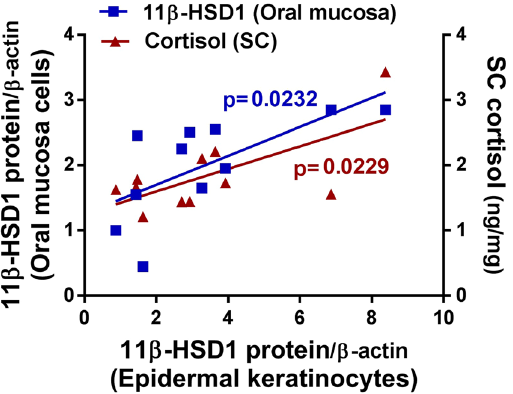
Figure 2. Expression of 11 β -HSD1 in oral mucosal cells obtained by a non-invasive method may be used as a proxy for 11 β -HSD1 expression in epidermal keratinocytes (n = 11). Foreskins were collected during circumcision. Oral mucosa was also collected by buccal swab just before surgery. 11 β -HSD1 protein expression in the epidermis was well correlated with 11 β -HSD1 protein expression in oral mucosa (blue) and cortisol of stratum corneum